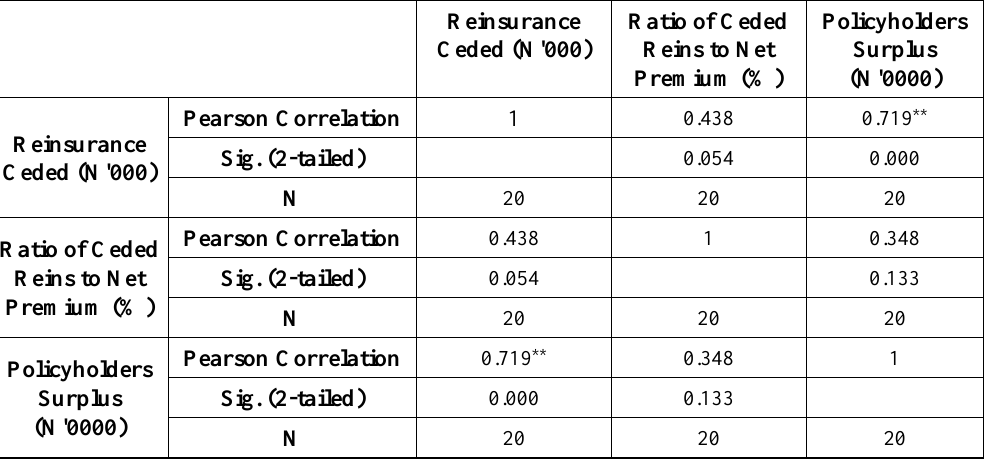
Table 3. Correlation Analysis of Reinsurance Capacity on Policyholders